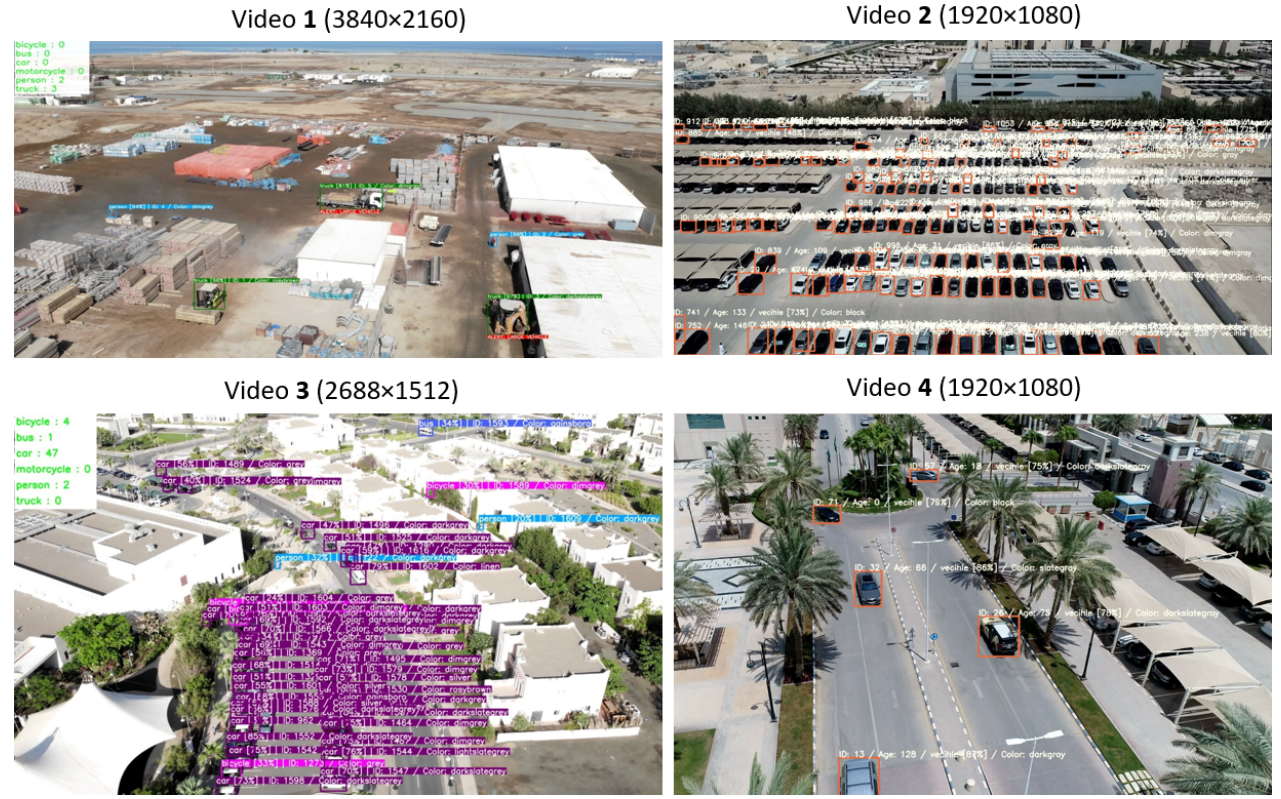
Figure 5. Sample frames from the output of the four videos used for the evaluation of the AI-enabled system, with different